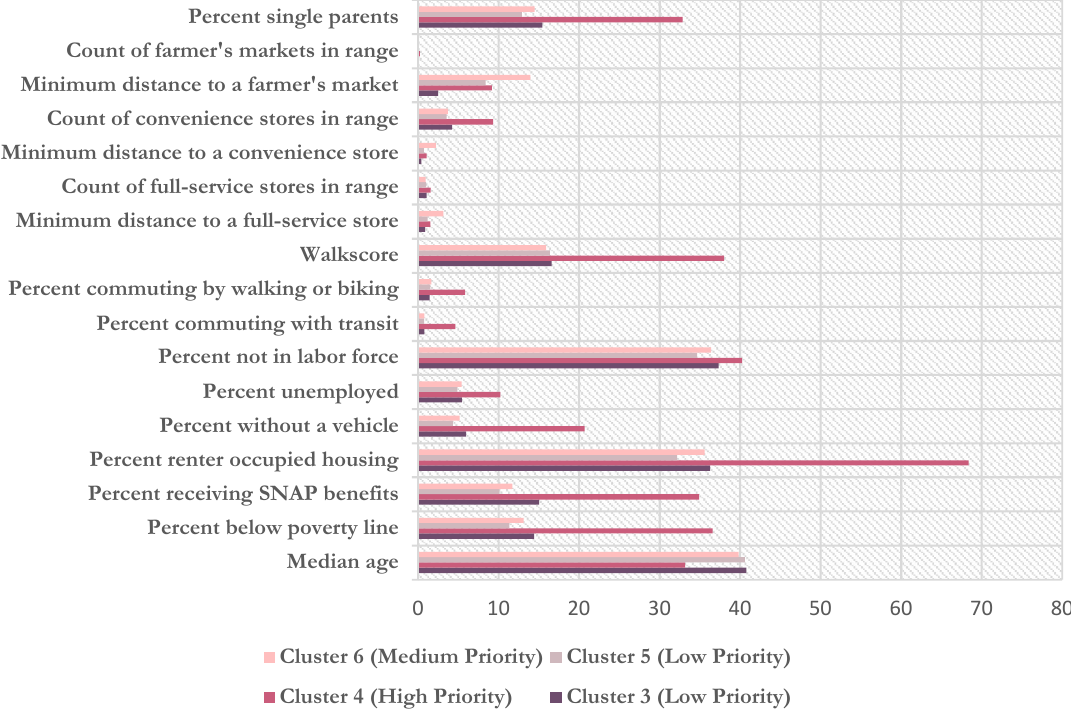
Figure 5. Average values of each variable belonging to the three rural clusters.